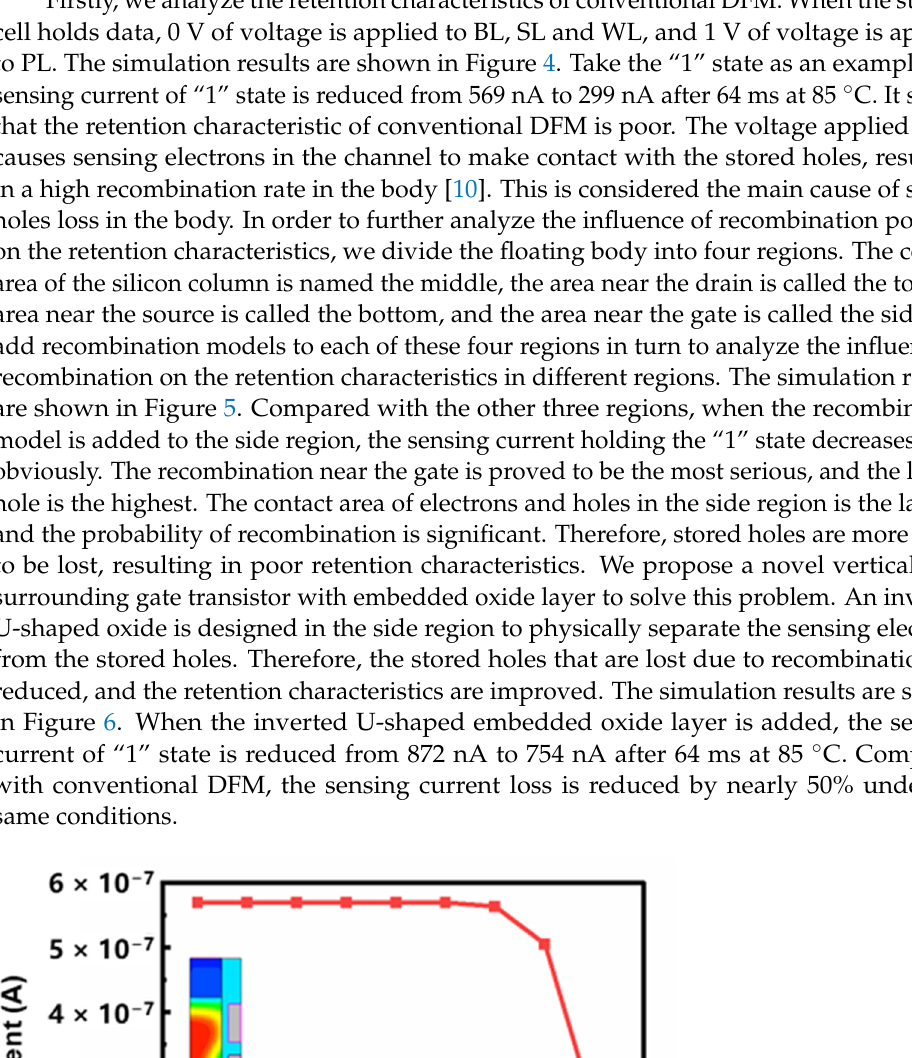
Figure 5. The reading current of different regions of the conventional DFM after holding “1” state for different times at 85 °C.